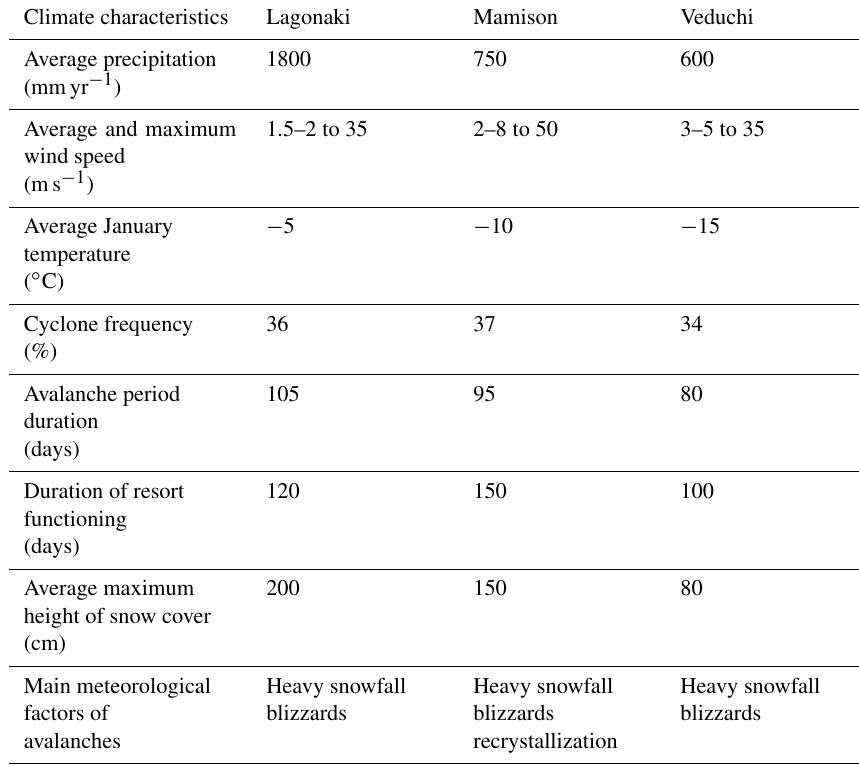
Table 1. Climate characteristics in Lagonaki, Mamison and Veduchi regions (Komarov, 2013). Climate characteristics